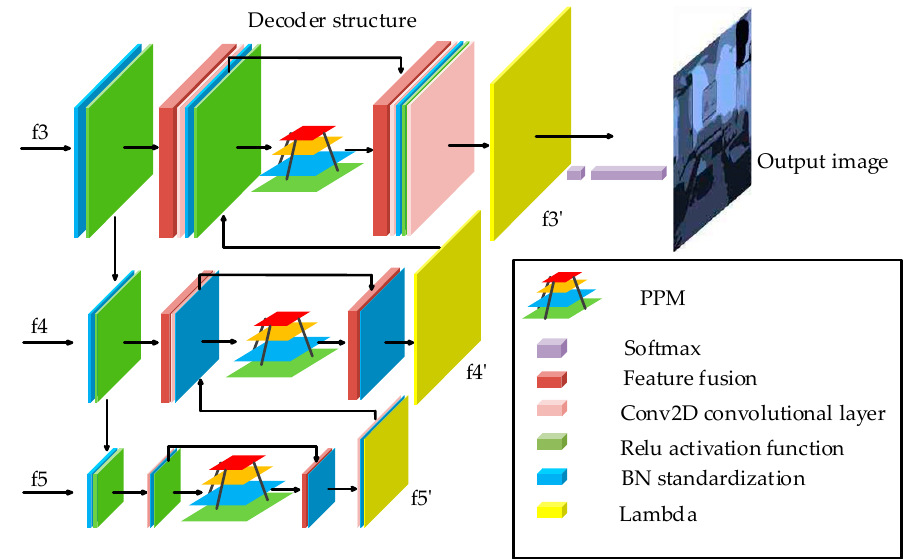
Figure 4. Decoder network structure.